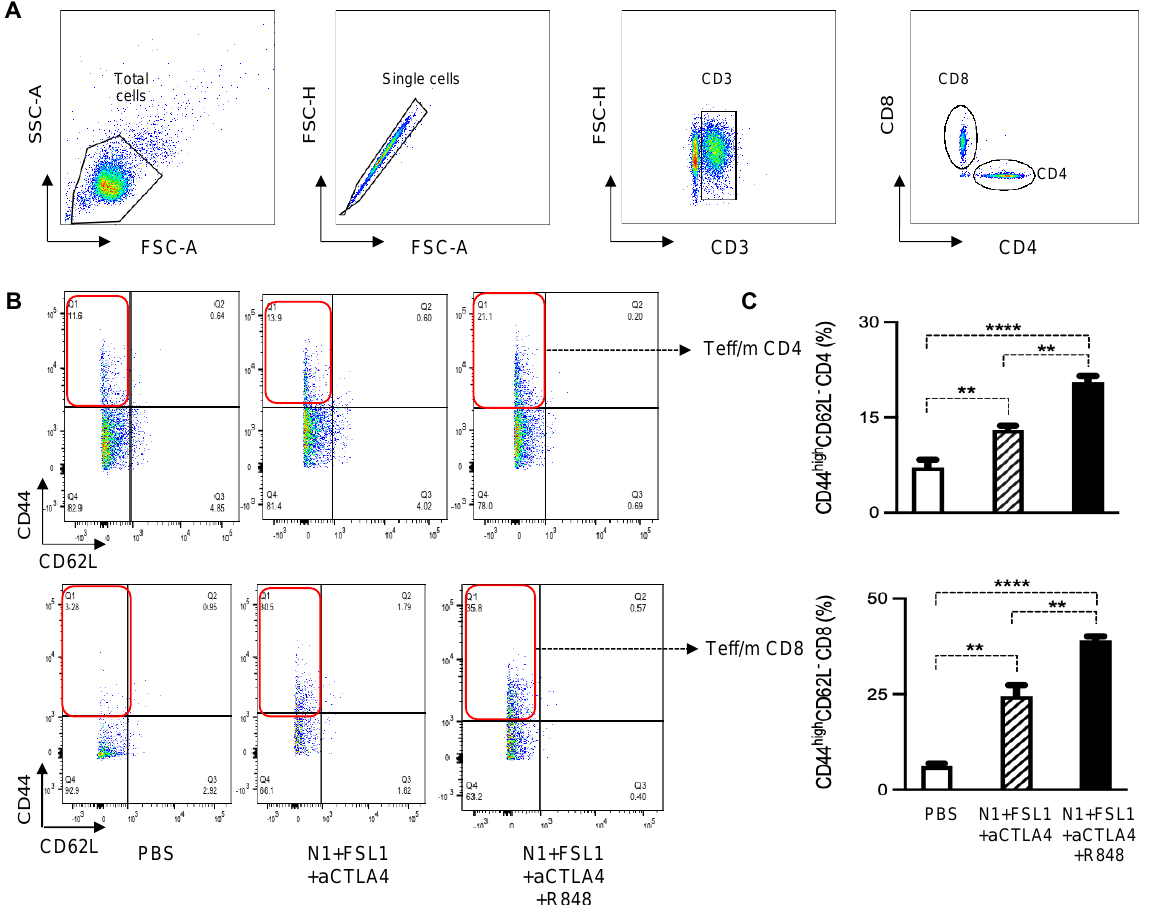
Figure 5. Treatment with the combination of N1, FSL-1, R848, and α CTLA-4 antibody elevated the levels on effector/memory CD4+ and CD8+ T cells in draining lymph nodes (dLNs). ( A ) Gating strategy. ( B ) The effector and memory (Teff/m) of CD4+ and CD8+ T cells of one representative mouse dLN. ( C ) The average (mean ± SEM, n = 5) levels of effector/memory CD4+ (CD4+CD44 high CD62L-) and effector/memory CD8+ (CD8+CD44 high CD62L-) T cells, respectively, in tumor dLNs. ** p < 0.01; and **** p < 0.0001.